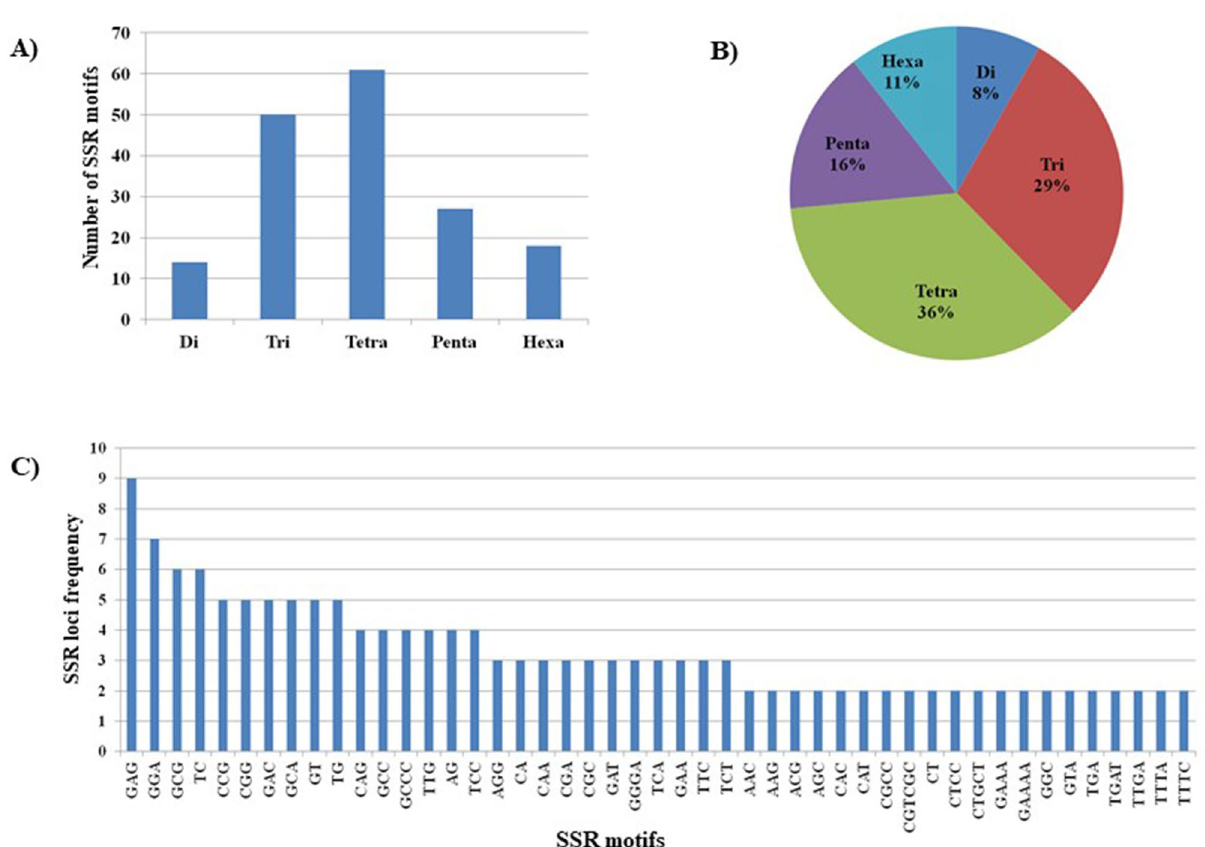
Figure 7. Frequency and distribution of salt stress responsive cg-SSRs and MIR-SSRs in wheat. ( A ) Number of different SSR motifs found, ( B ) Percentage of different SSR loci present in salt stress responsive genes ( C ) SSR loci frequency in salt stress responsive genes (only ≥ 2 times repeated SSR loci shown in the figure, For completed list refer Supplementary Table